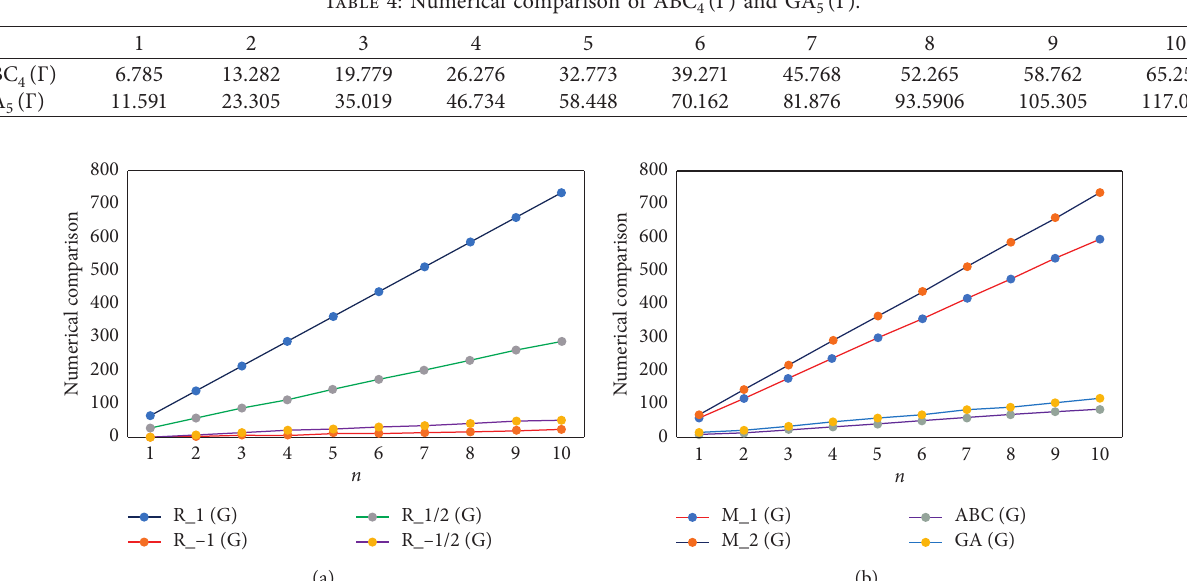
Table 4: Numerical comparison of ABC